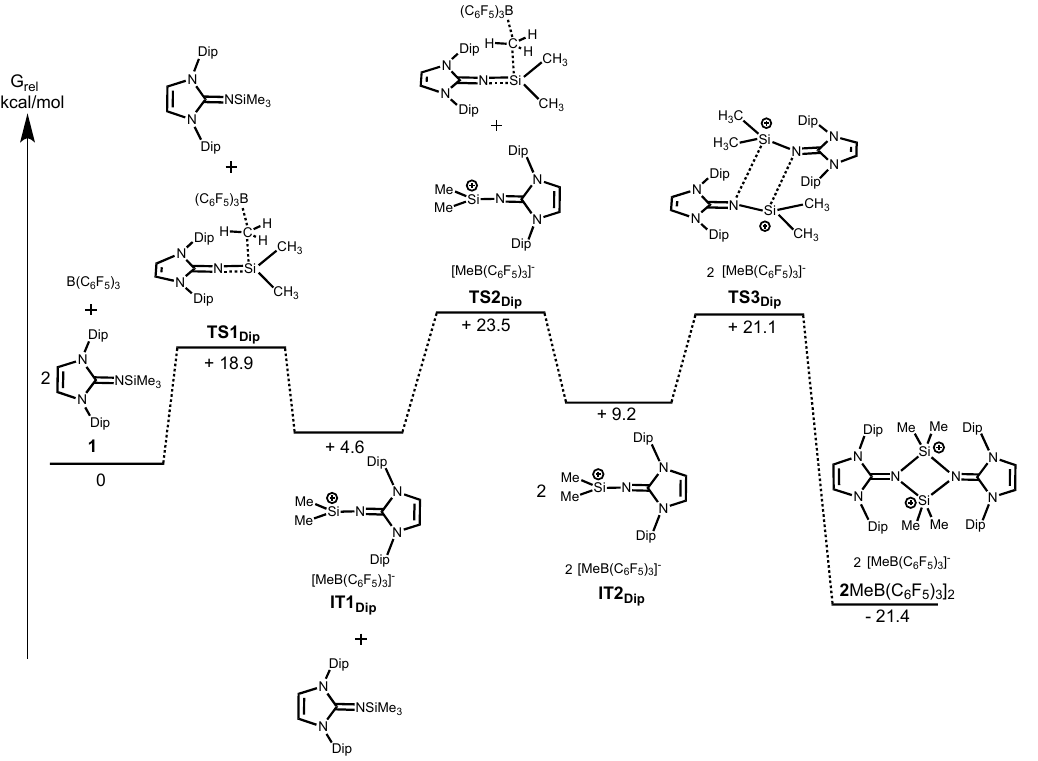
Figure 3. Reaction profile for the reaction of 1 with B(C 6 F 5 ) 3 (Dip = 2,6-diisopropylphenyl).